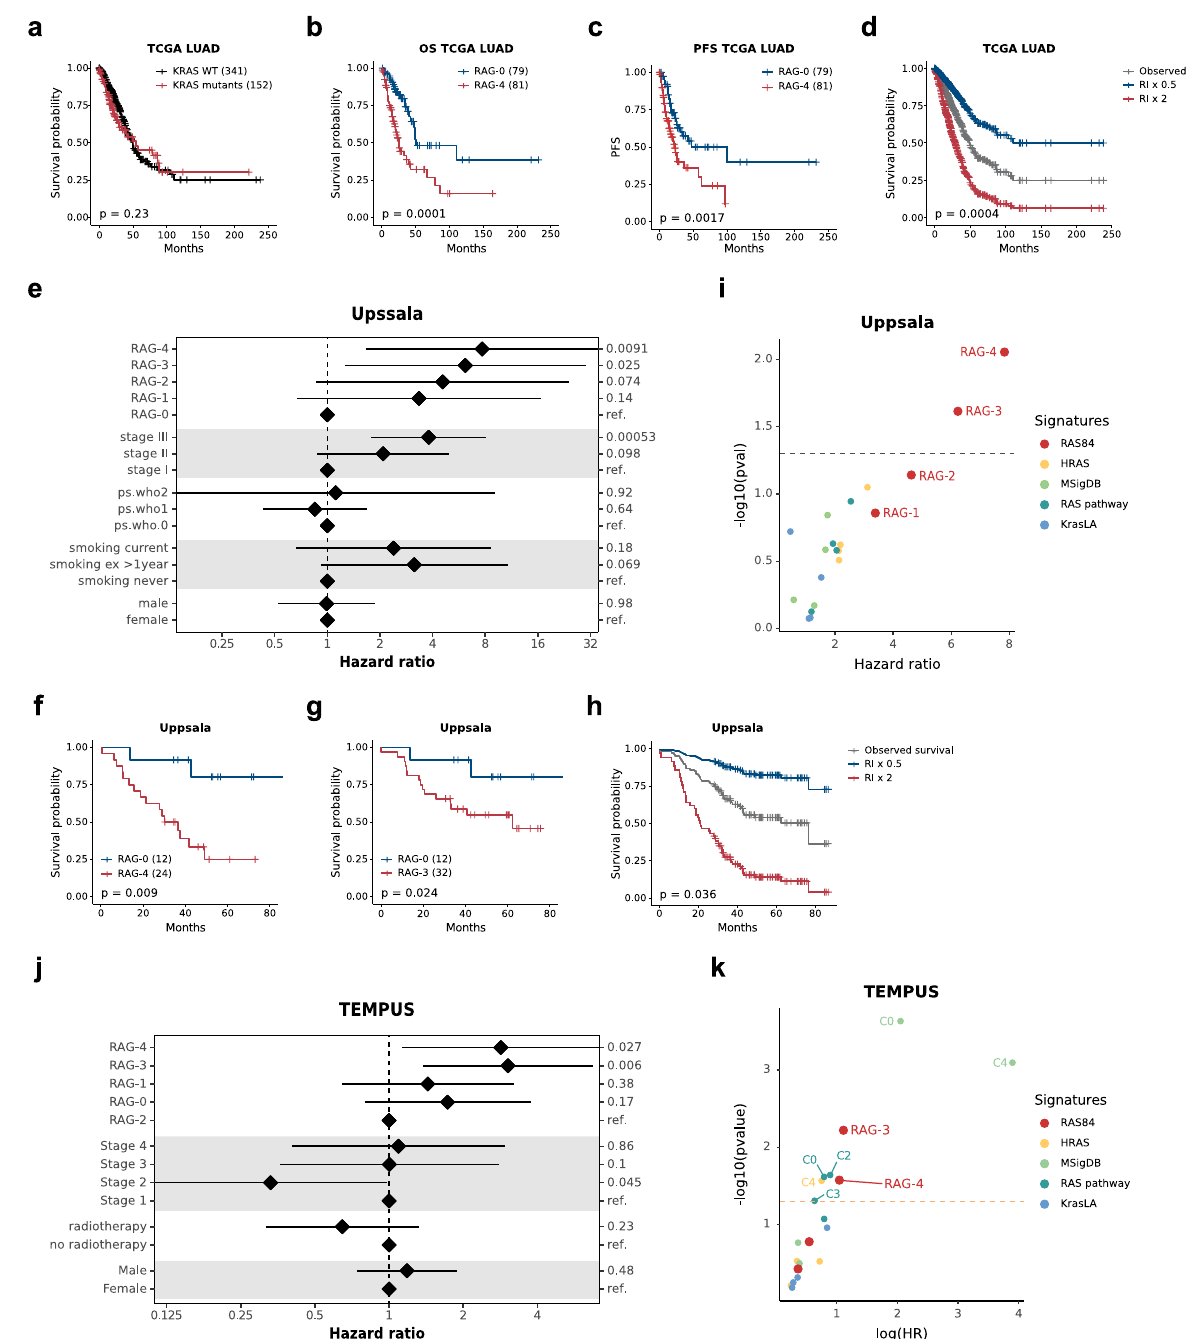
Fig.5|RAS84predictssurvivalinlungadenocarcinoma.a – d Kaplan – Meierplots showingoverallsurvivaldatafromtheTCGALUADcohortforpatientsstrati fi edby KRAS mutation (coxph p -value 0.23) ( a ) or from RAG-4 and RAG-0 (coxph p -value 0.0001) ( b ), progression-free survival data from the TCGA LUAD cohort for patientsfrom RAG-4 and RAG-0 (coxph p -value 0.0017)( c )and a Cox proportional hazards regression fi t of TCGA LUAD survival data to RI values. The grey survival curve shows the observed data. The blue survival curve is the predicted survival if the RI values decreased 2-fold. The red curve is the predicted survival values if the RI were to increase 2-fold (coxph p -value 0.0004) ( d ), Patient number is indicated between brackets. e Forest plot showing results from a multivariate Cox propor- tional hazards analysis of the Uppsala lung adenocarcinoma cohort ( n = 103 patients). Hazard ratios and 5 and 95% con fi dence intervals are shown on a natural log scale. f – h Kaplan – Meier plots showing overall survival data from the Uppsala cohortforpatientsfromRAG-4andRAG-0(multivariatecoxph p -value0.0088)( f ),